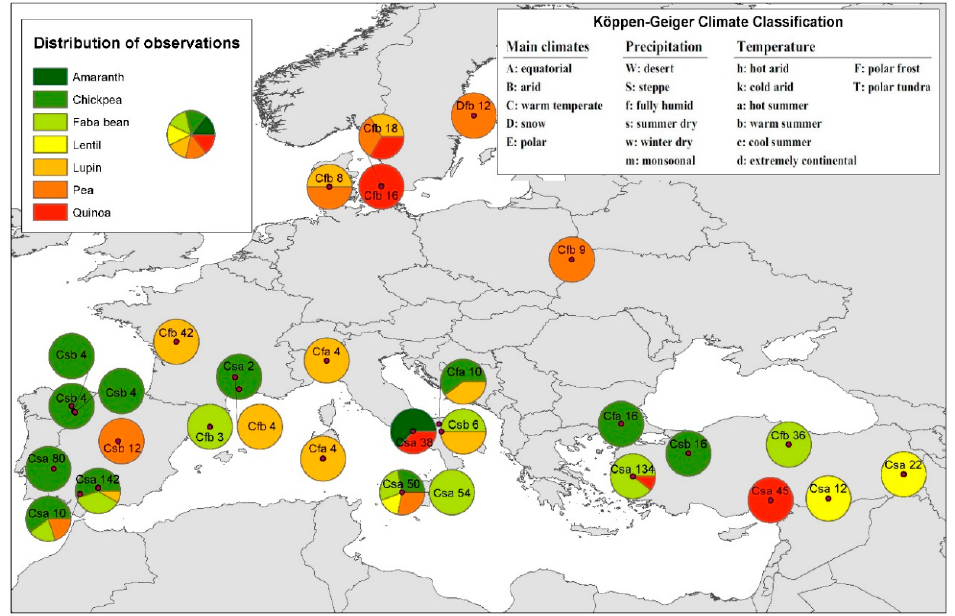
Figure 3. Distribution of doughnut chart of all observations (n = 818) by crops (amaranth, chickpea, faba bean, lentil, lupin, pea, and quinoa), by Köppen-Geiger climate classification zones (warm temperate climate zone (fully humid and summer dry, i.e., Cfa, Cfb, Csa, Csb, Csc); the snow climate zone (fully humid, i.e., Dfb)) and study sites on the map of Europe. The writing in each doughnut chart represents the climate classification and the total number of observations for each study area.